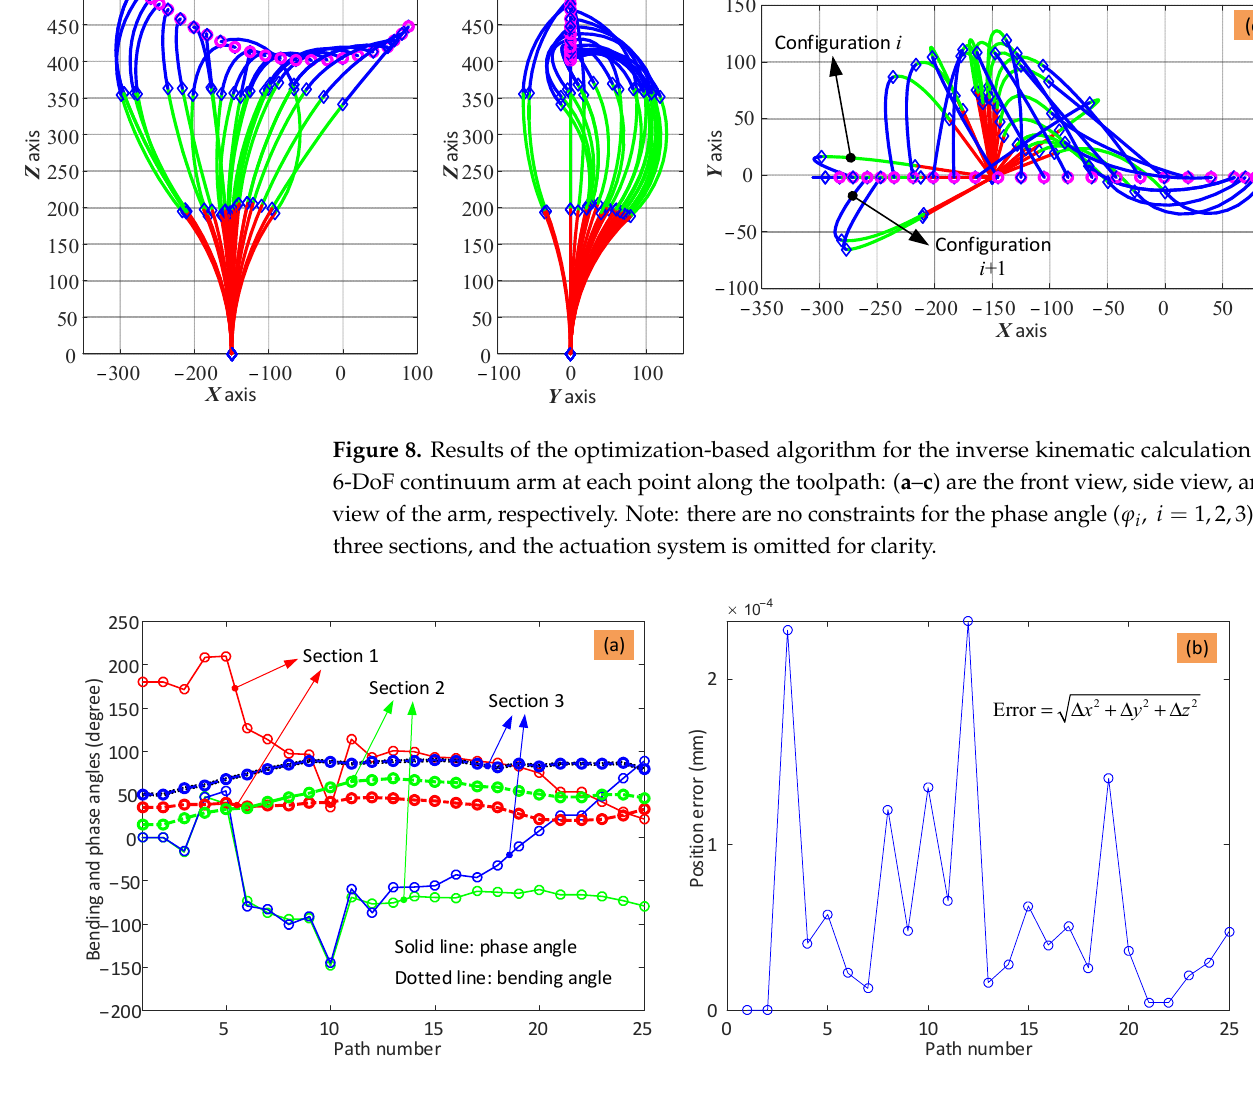
Figure 9. Change in shape parameter for each section of the arm and the optimization accuracy: ( a ) is the variation of the bending angle and phase angle of the three sections; ( b ) is the deviation between the calculated path and desired path. Note: the error is obtained by calculating the distance between the desired path and the planned path (error = (cid:3493)∆𝑥 (cid:2870) + ∆𝑦 (cid:2870) + ∆𝑧 (cid:2870) ). It can be seen from Figure 9a that the bending angle and phase angle of the three sections change to control the end effector position. The bending angle is limited in the optimization algorithm to stay in the range [0 ◦ , 90 ◦ ], which is observed for each section. The phase angles are not constrained, and while they stay within the same quadrant most of the time as the end effector moves from point to point, occasionally, the phase angle jumps to another quadrant. This is bad for the performance of the system. Taking the phase angle of Section 2 as an example (green dotted line), the angle jumps into a different quadrant at step 4 and returns to the initial quadrant at step 6. The main reason is that there are multiple solutions for the shape configuration of the continuum arm for any given tip position due to the symmetrical structure of the arm. It can be seen from Figure 9b that high accuracy is still achieved; that is, the position errors between the planned toolpath and desired toolpath are within 0.3 µ m, despite of these jumps in